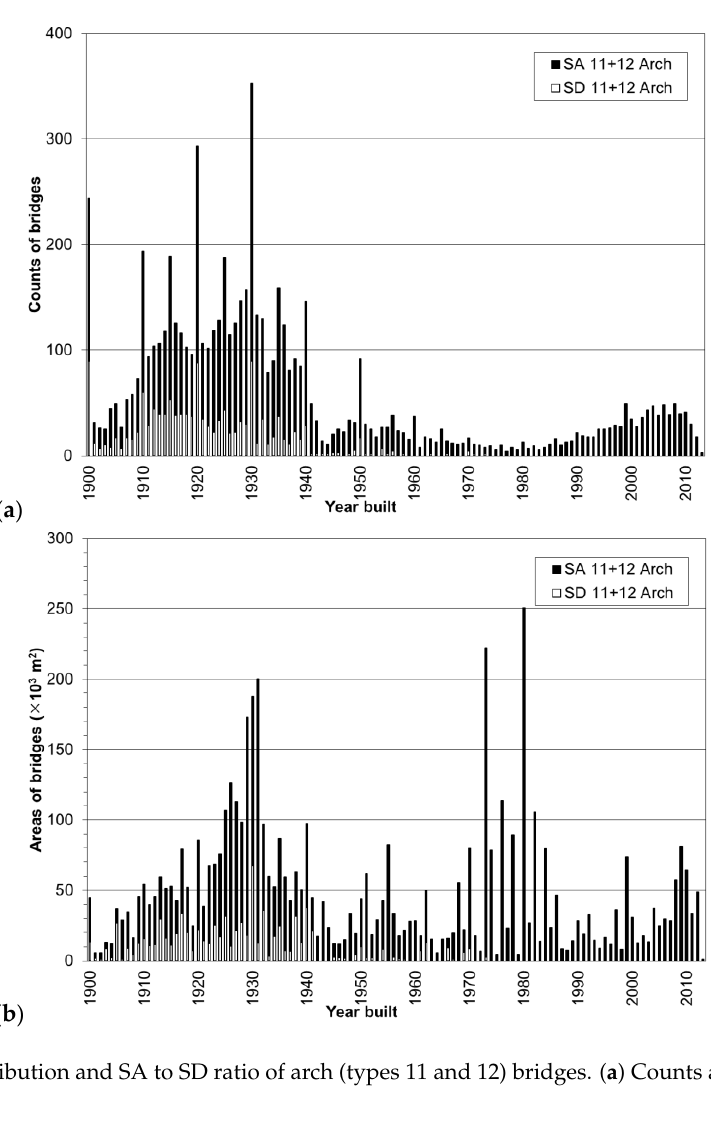
Figure 5. Distribution and SA to SD ratio of arch (types 11 and 12) bridges. (a) Counts and (b) Areas.